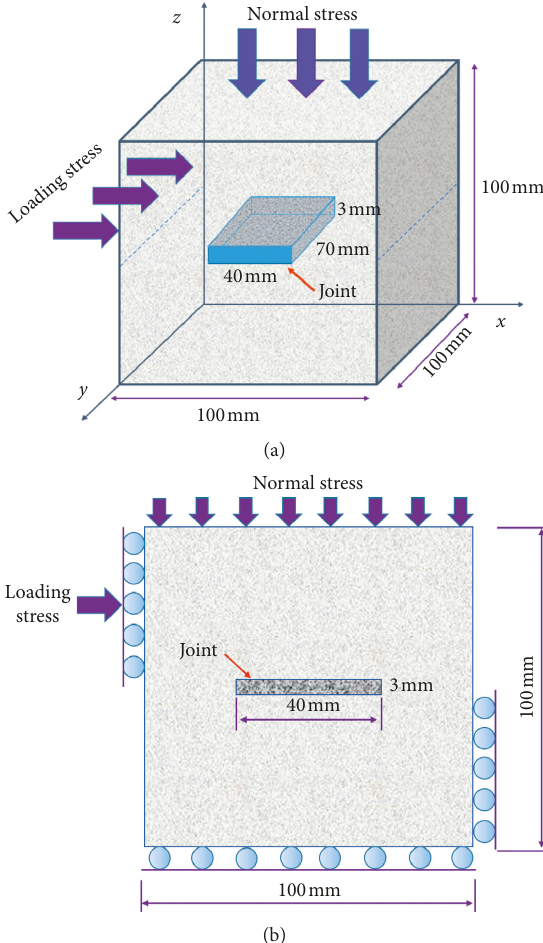
Figure 5: λ � 40% specimen shear diagram. (a) Joint specimen stereogram and (b) joint specimen